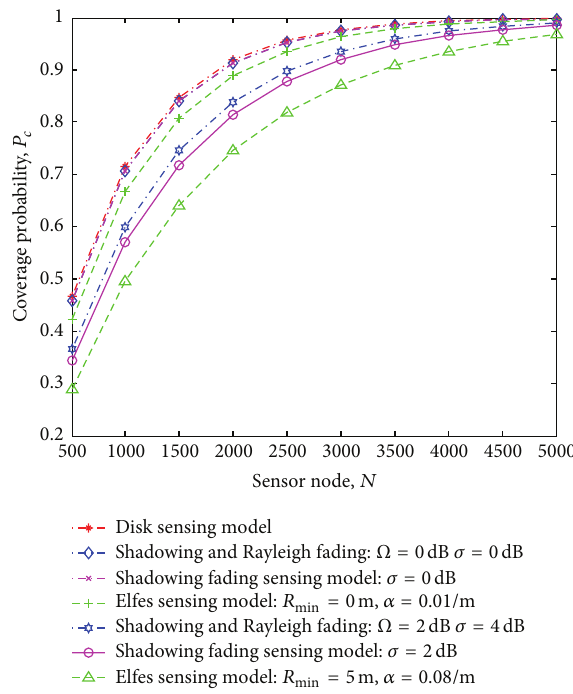
Figure 7: Coverage probability 𝑃 𝑐 versus Number of sensor nodes using different sensing